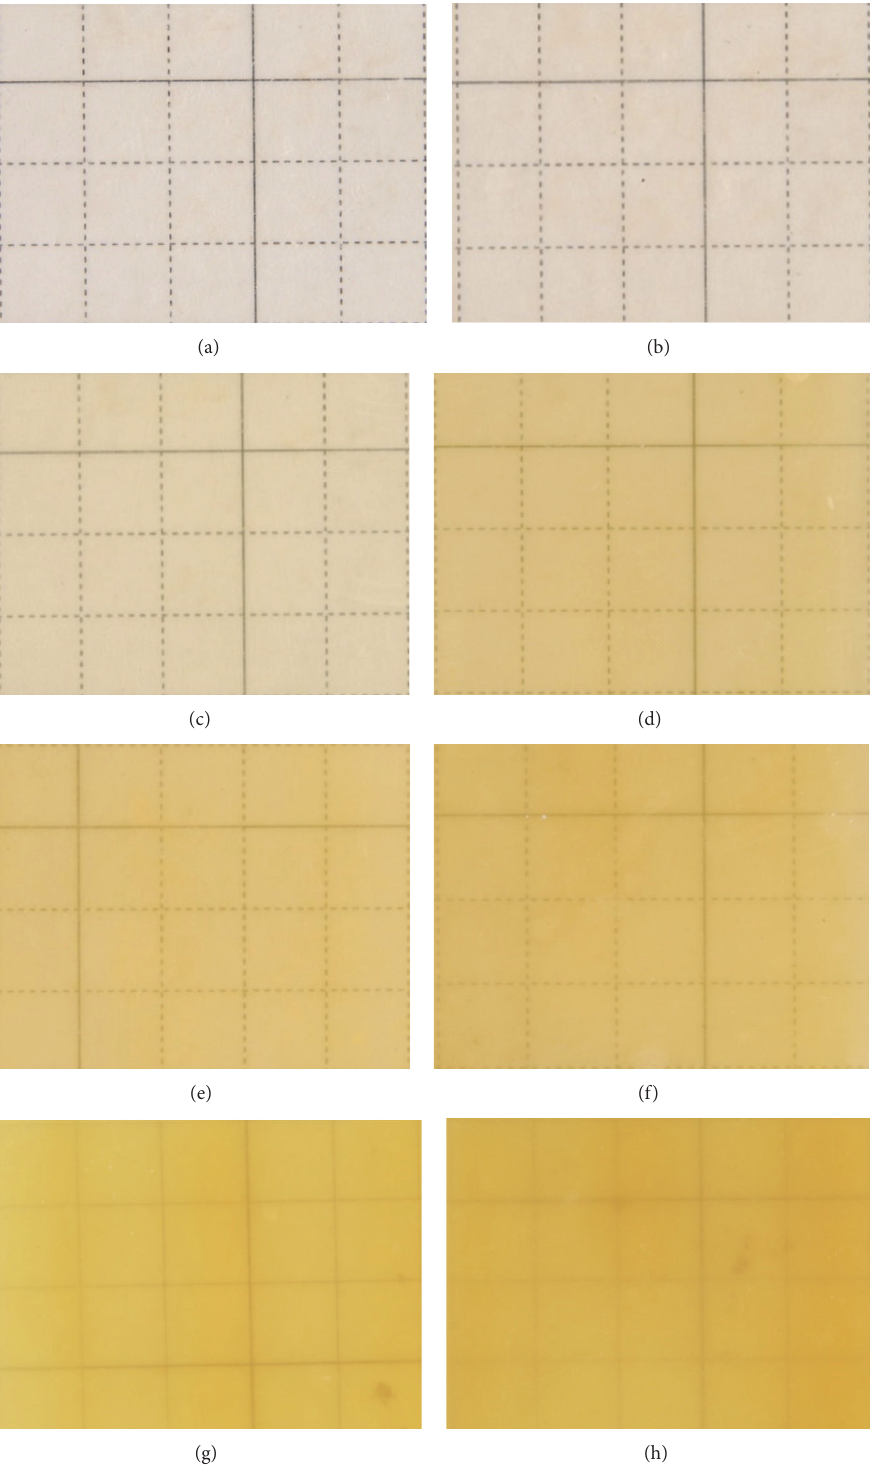
Figure 1: Surface morphology of PS exposed in Xisha Island: (a) original sample; (b) 1-month exposure; (c) 3-month exposure; (d) 6-month exposure; (e) 9-month exposure; (f) 12-month exposure; (g) 18-month exposure; (h) 24-month